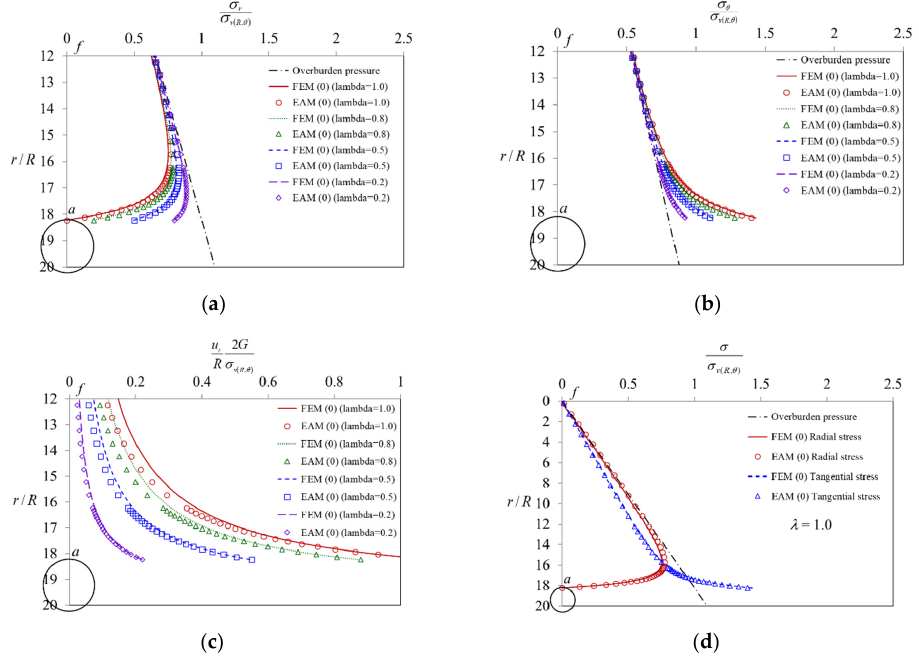
Figure 14. Ground reaction around the tunnel obtained by EAM and FEM with the different incre- mental values of λ in an elastic media, and the distribution of ( a ) radial stress, ( b ) tangential stress, ( c ) radial displacement, and ( d ) tangential and radial stresses with λ = 1.0 (Case I, θ = 0°, along the ground surface line and K o = 0.8).